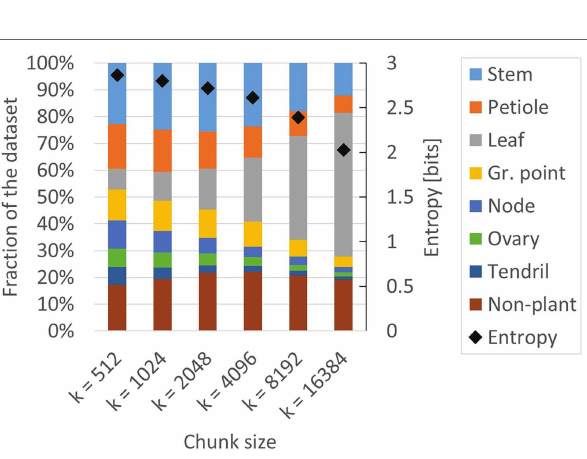
FIGURE 6 | Composition of the six training sets created for experiment 2. All datasets are based on the class-dependent sampling strategy using six different values for k . The black diamonds show the level of entropy (secondary axis) according to Eq.